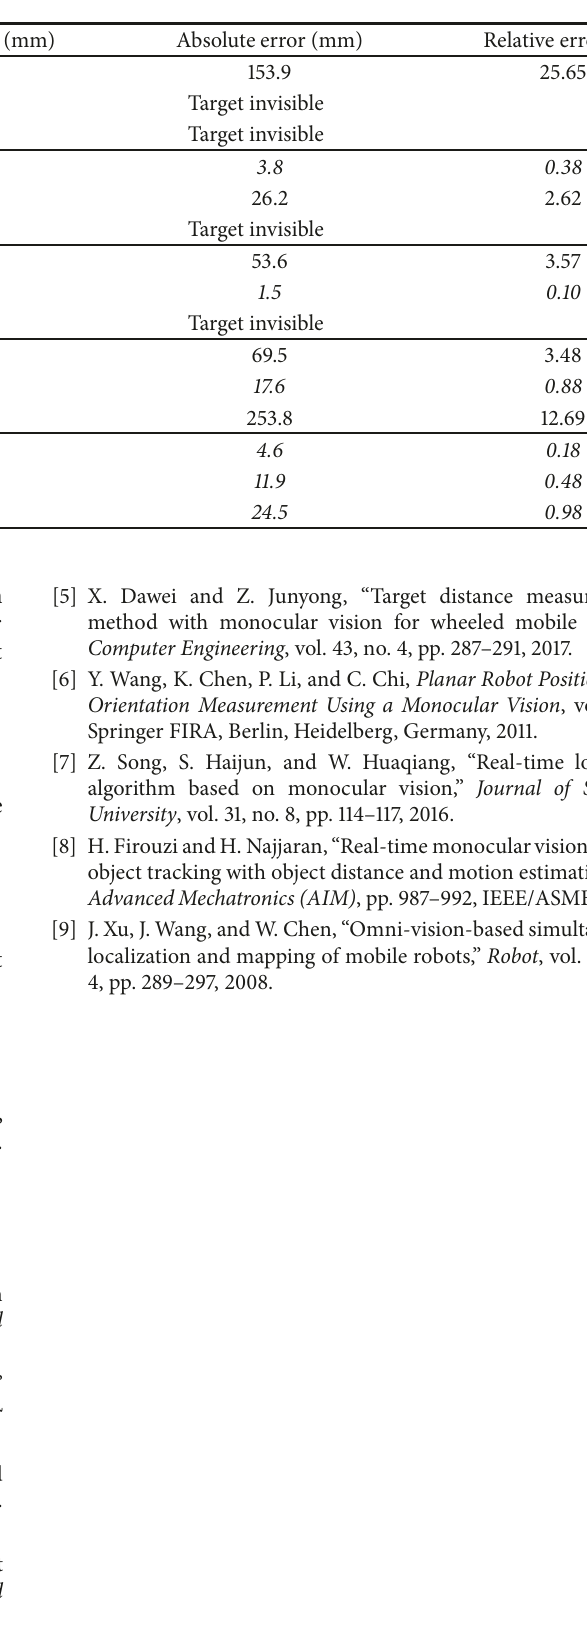
Table 2: Comparison table of actual distance and visual ranging between the target and the mobile robot from near to far with different tilt